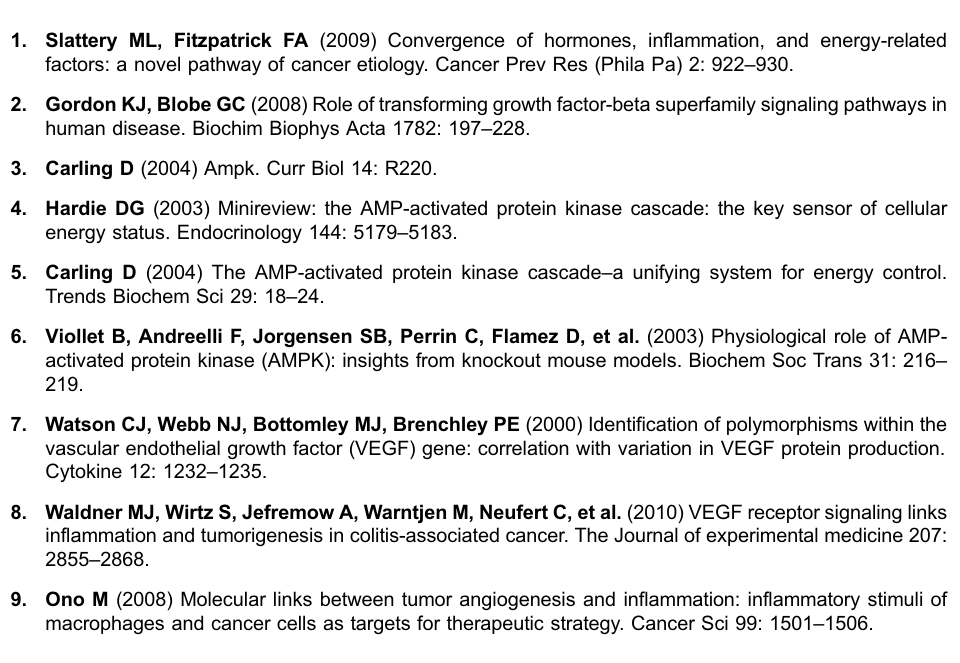
S3 Table. Genes and related SNPs associated with colorectal cancer-specific mortality among patients diagnosed with colon cancer (0.05 . gene # 0.10; SNP P # 0.10). P ARTP trend S4 Table. Genes and related SNPs associated with colorectal cancer-specific mortality among patients diagnosed with rectal cancer (0.05 . gene # 0.10; SNP P # P ARTP trend